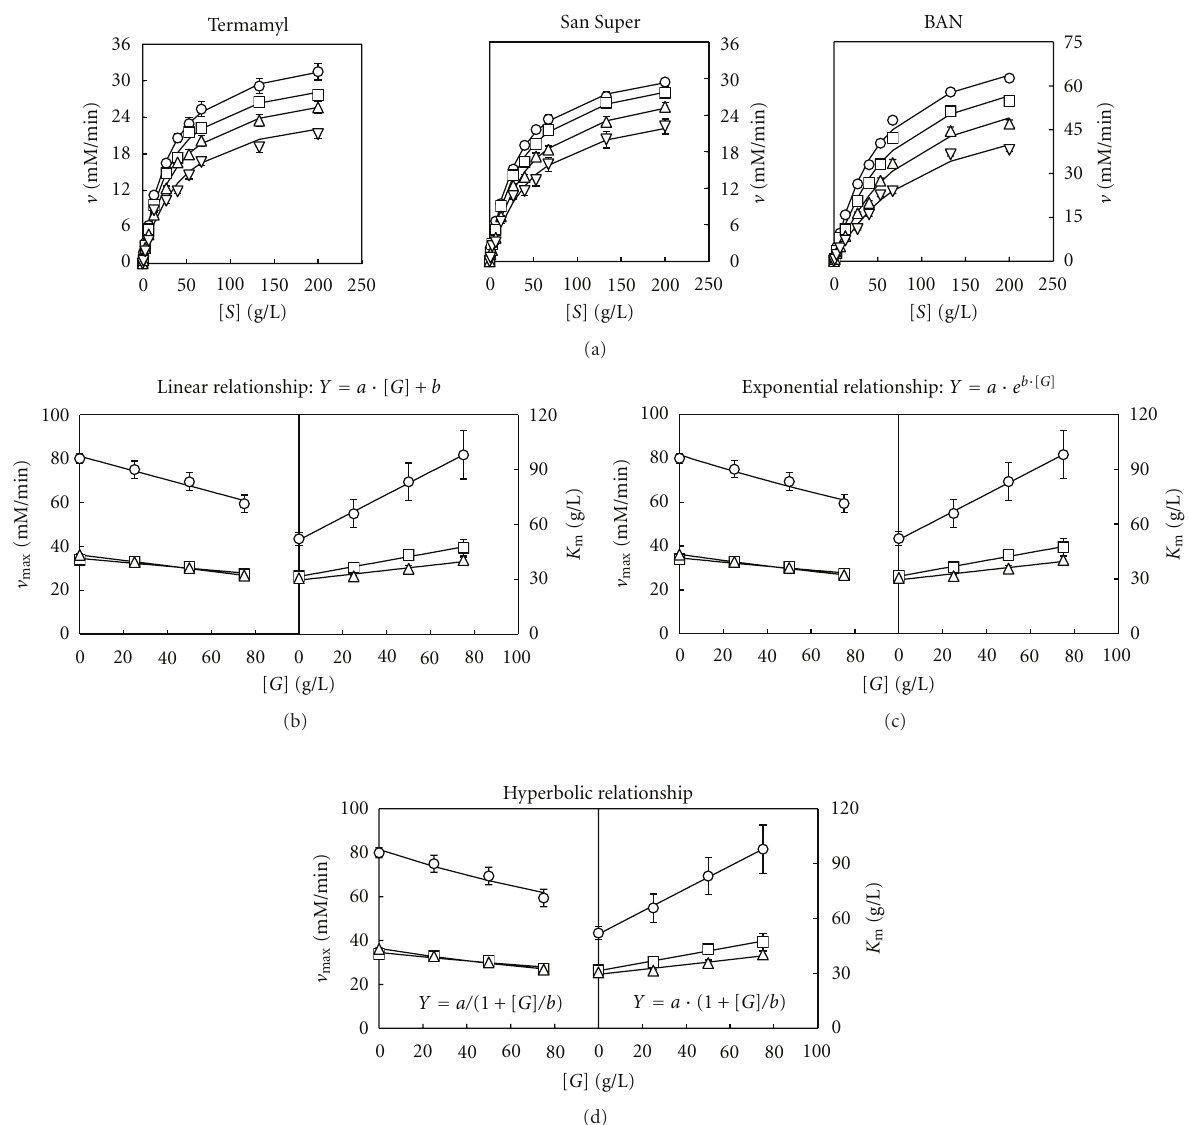
Figure 5: Changes in the experimental amylolytic activity ( v ) data (means ± standard deviations) with the concentration of starch (O) and starches mixed with initial gelatine concentrations [ G ] of 25 g/L ( (cid:2) ), 50 g/L ( (cid:3) ), and 75 g/L ( ∇ ). The curves drawn through the experimental velocity data in (a) were obtained according to the Michaelis-Menten model (1). The curves drawn through the v max and K M data (as means ± standard errors) for the enzymes BAN (O), San Super ( (cid:2) ), and Termamyl ( (cid:3) ) were obtained according to a linear (b), exponential (c), and hyperbolic (d) equation. Y represents the predicted values for v max and K M , a , and b are